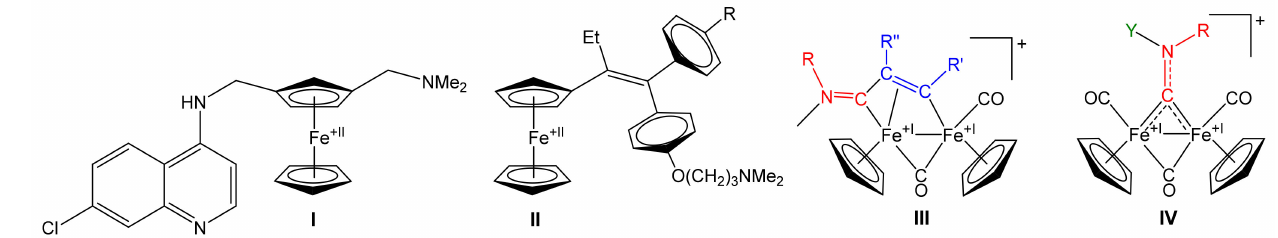
Figure 1. Structuresofselectedironcomplexeswithreportedbiological(anticancer)activity. a)Ferrocenederivatives: ( I )ferroquine, antimalarial drug investigated in clinical trials; ( II ) ferrocifens (R=H, OH), derived from conjugation of ferrocene with the anticancer drug tamoxifen; ( III ) Diiron µ -vinyliminium complexes with structural variability from combination of isocyanide (CNR, red) and alkyne (R (cid:48) C ≡ CR”, blue) reagents (R=Me, 2,6-C 6 H 3 Me 2 ); ( IV ) Diiron µ -aminocarbyne complexes able to transfer Y + (green) to